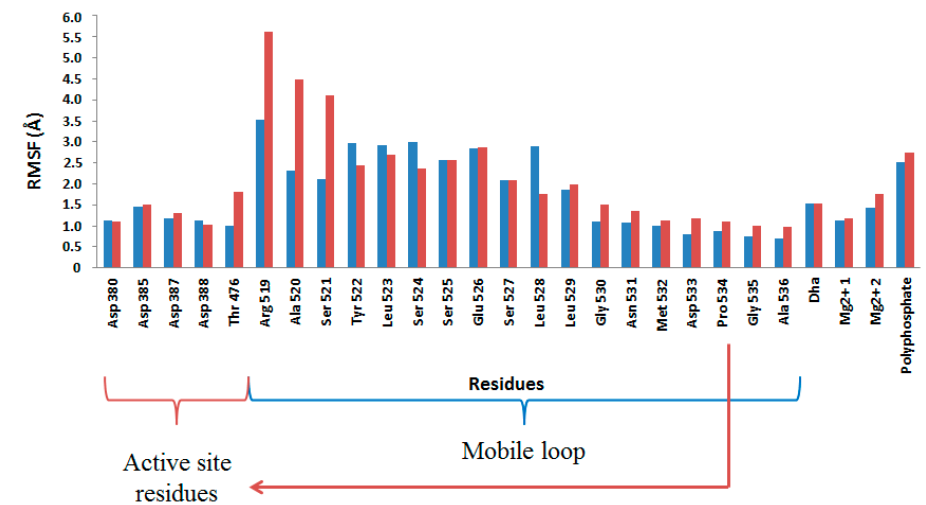
Figure 9. Root Mean Square Fluctuation (RMSF, in Å) of key residues computed from the last 5 ns of the MD simulation on the wild-type (blue bars) and 1H2 mutant (red bars).